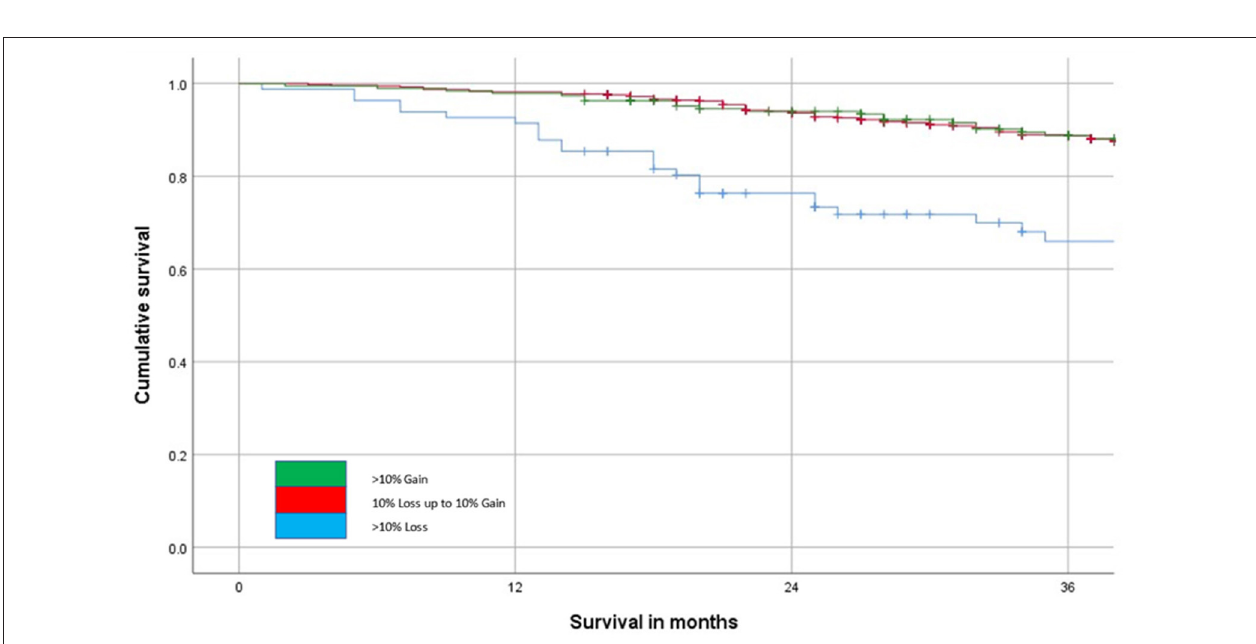
FIGURE 4 | The relationship between change in SMI on follow-up and overall survival ( n = 804, p < 0.001) over a 36-month follow-up period.